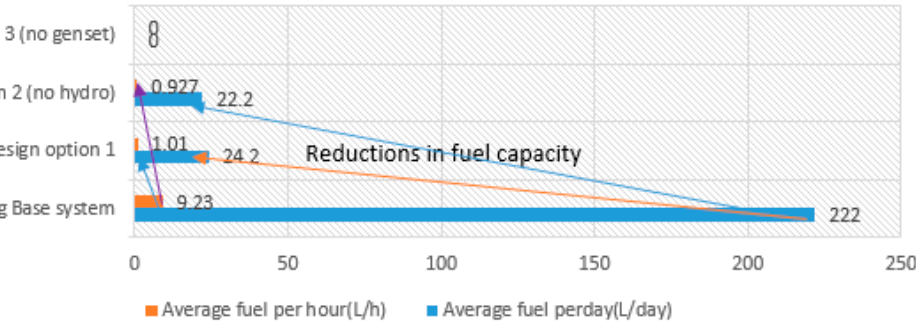
Figure 17. Comparison of systems’ average fuel consumption per day and per hour.